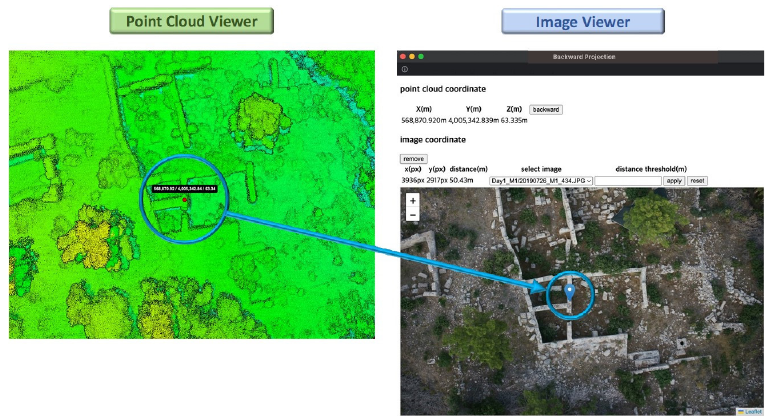
Figure 19. Illustration of the backward projection of a selected point (red dot) in a point cloud and the corresponding point in an image (blue placemark).